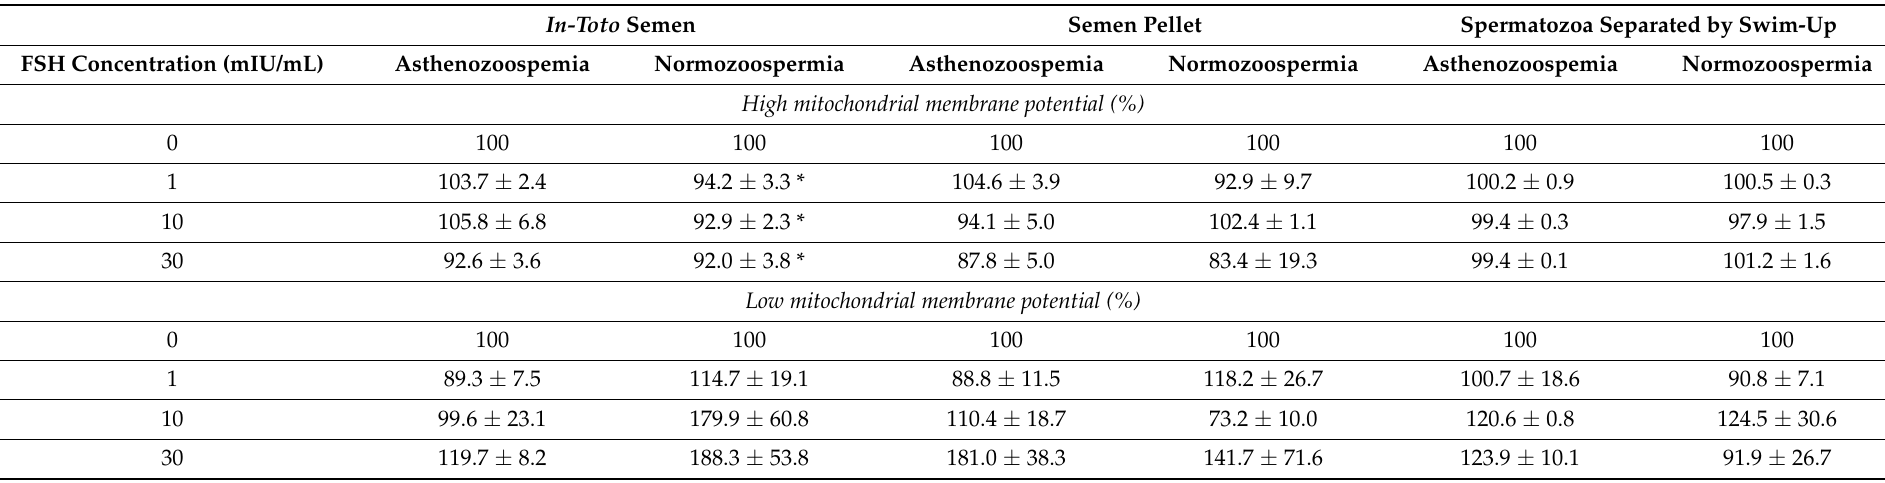
Table 1. Percentage (mean ± SEM) of spermatozoa with high or low mitochondrial membrane potential reported as percentage change from the control (FSH 0